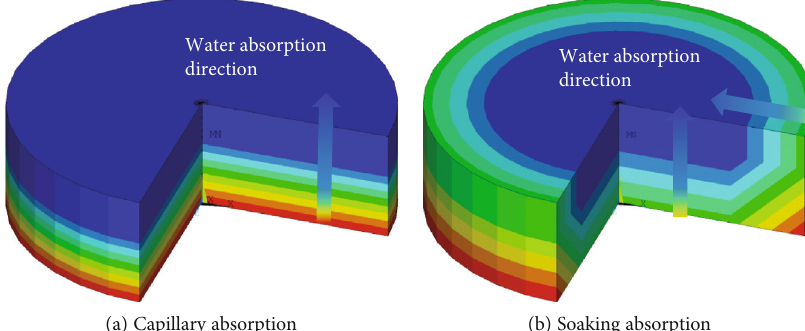
Figure 17: Numerical analysis model.